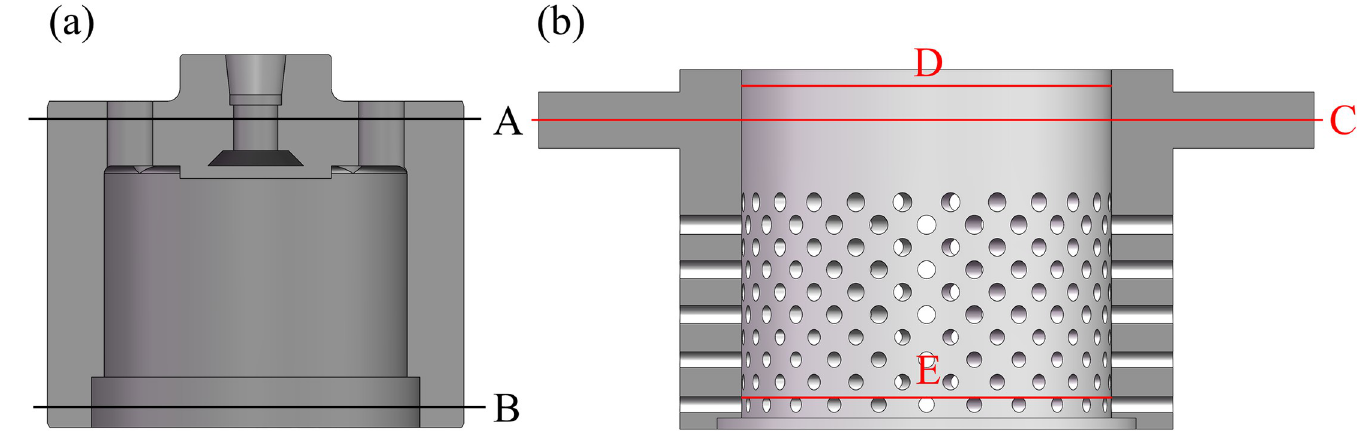
Fig 8. Measuring location of the valve trims. (a) Valve plug. (b) Inner sleeve.